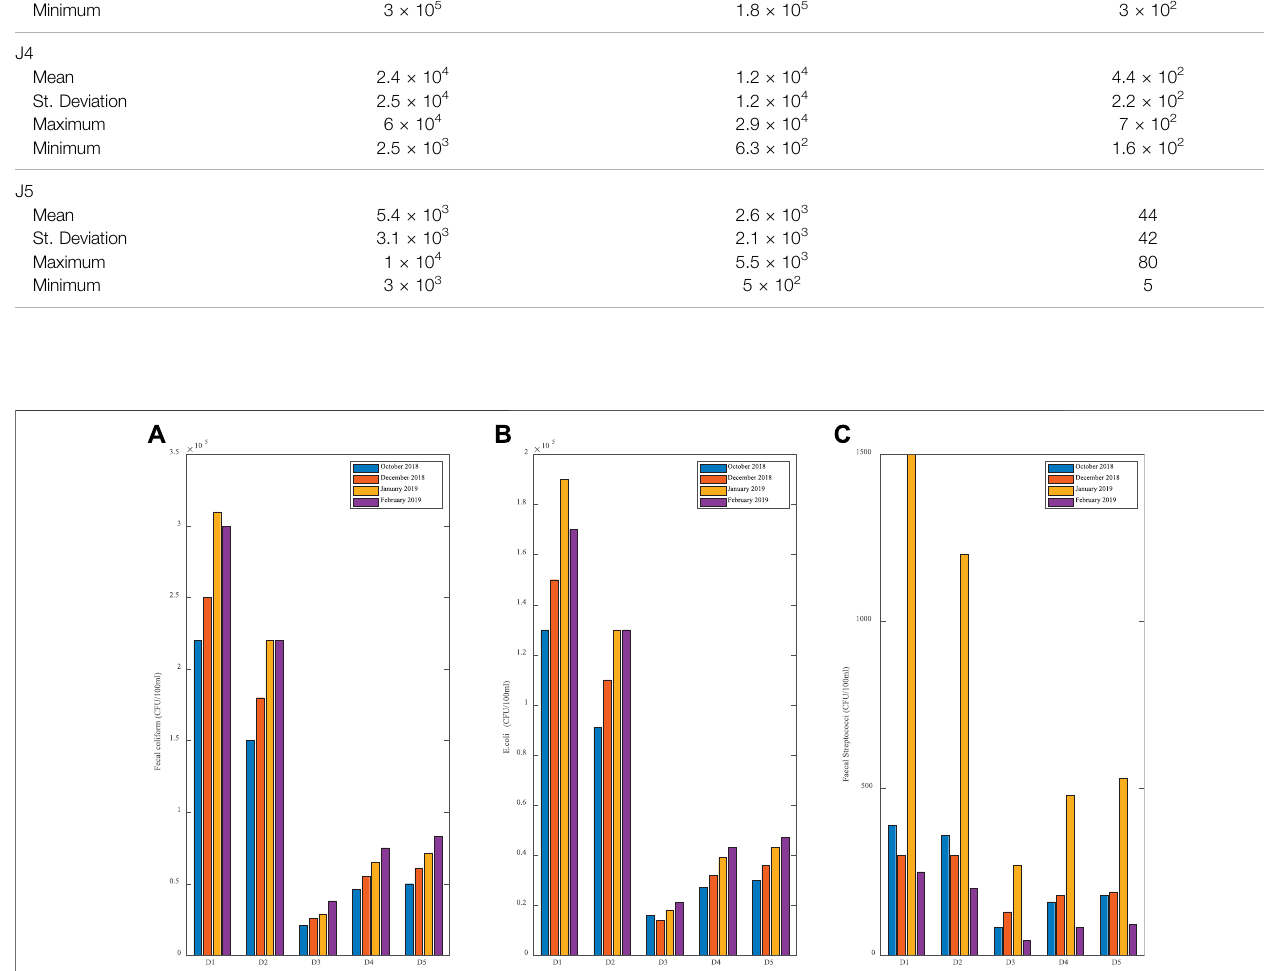
Frontiers in Environmental Science |